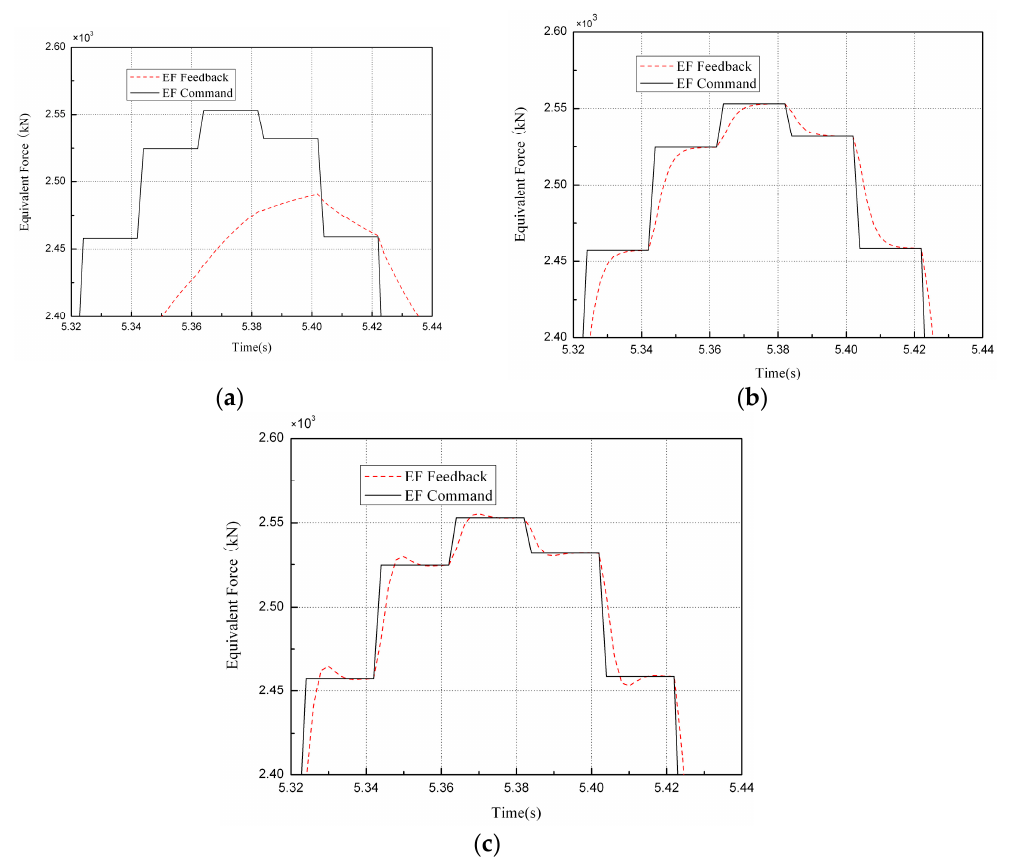
Figure 15. Comparison of the EF feedback and EF command: ( a ) K P = 0.05, K I = 0.001; ( b ) K P = 0.05, K I = 0.0065; ( c ) K P = 0.05, K I = 0.01.